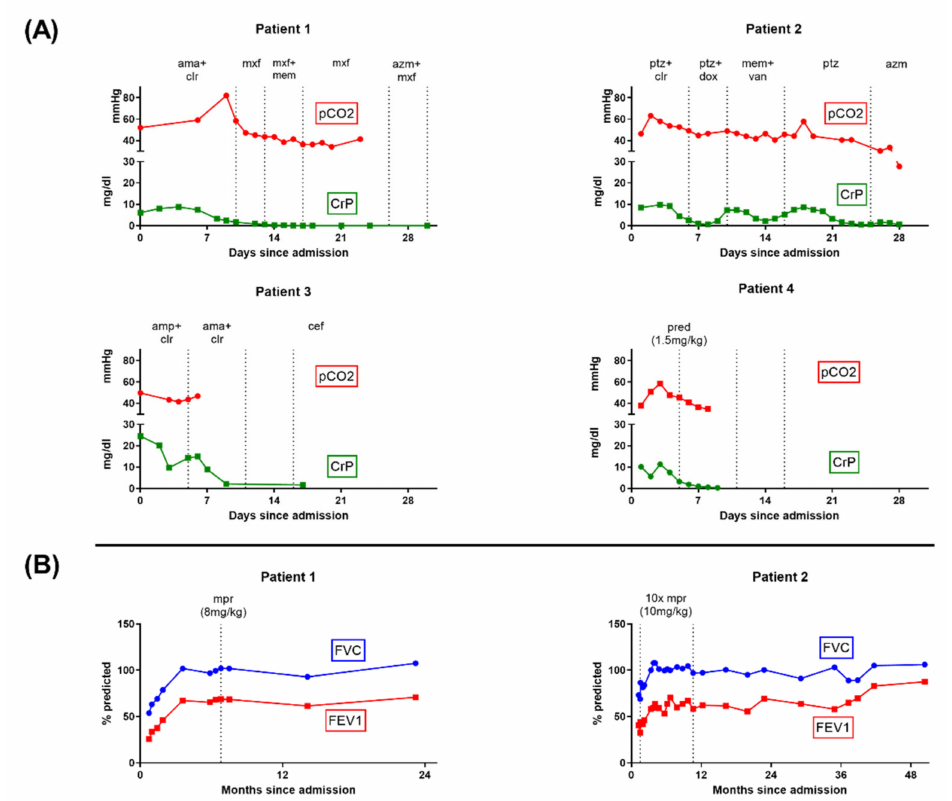
Figure 1. Clinical courses and spirometry results. ( A ) Results of pCO2 from blood gas analysis and C-reactive protein (CRP) from laboratory studies during hospitalization. Antibiotic treatment intervals are indicated. Additionally, the patients received systemic prednisolone for reduction in airway inflammation. All patients showed a normalization of pCO2 and CRP levels prior to discharge. ( B ) Spirometry results during follow-up and methylprednisolone burst treatments for Patients 1 and 2 (dosage indicated, each as daily dosage for 3 days). Initial spirometry showed peripheral obstruction, overinflation, increased airway resistance, and pseudorestriction in both patients. No spirometry follow-up was available for Patient 3 or 4. amp = ampicillin, ama = ampi- cillin/sulbactam, azm = azithromacin, cef = cefpodoxime, clr = clarithromycin, dox = doxycycline, CT = computed tomography, mem = meropenem, mpr = methylprednisolone burst, mxf = moxifloxacin, ptz = piperacillin-tazobactam, pred = prednisolone, and van =